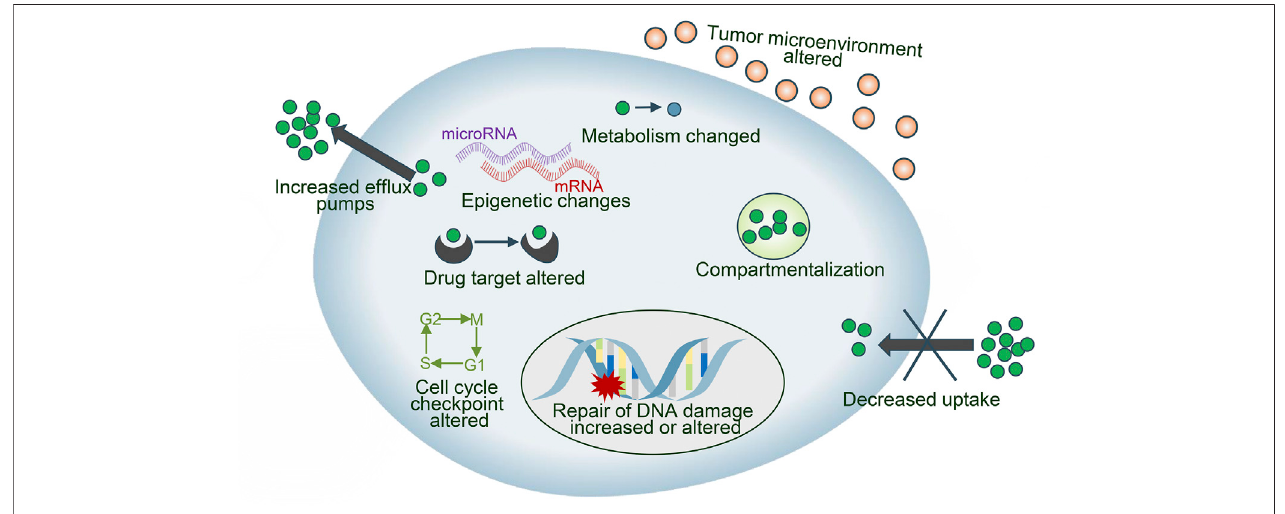
FIGURE 2 | Different mechanisms involved in anticancer drug